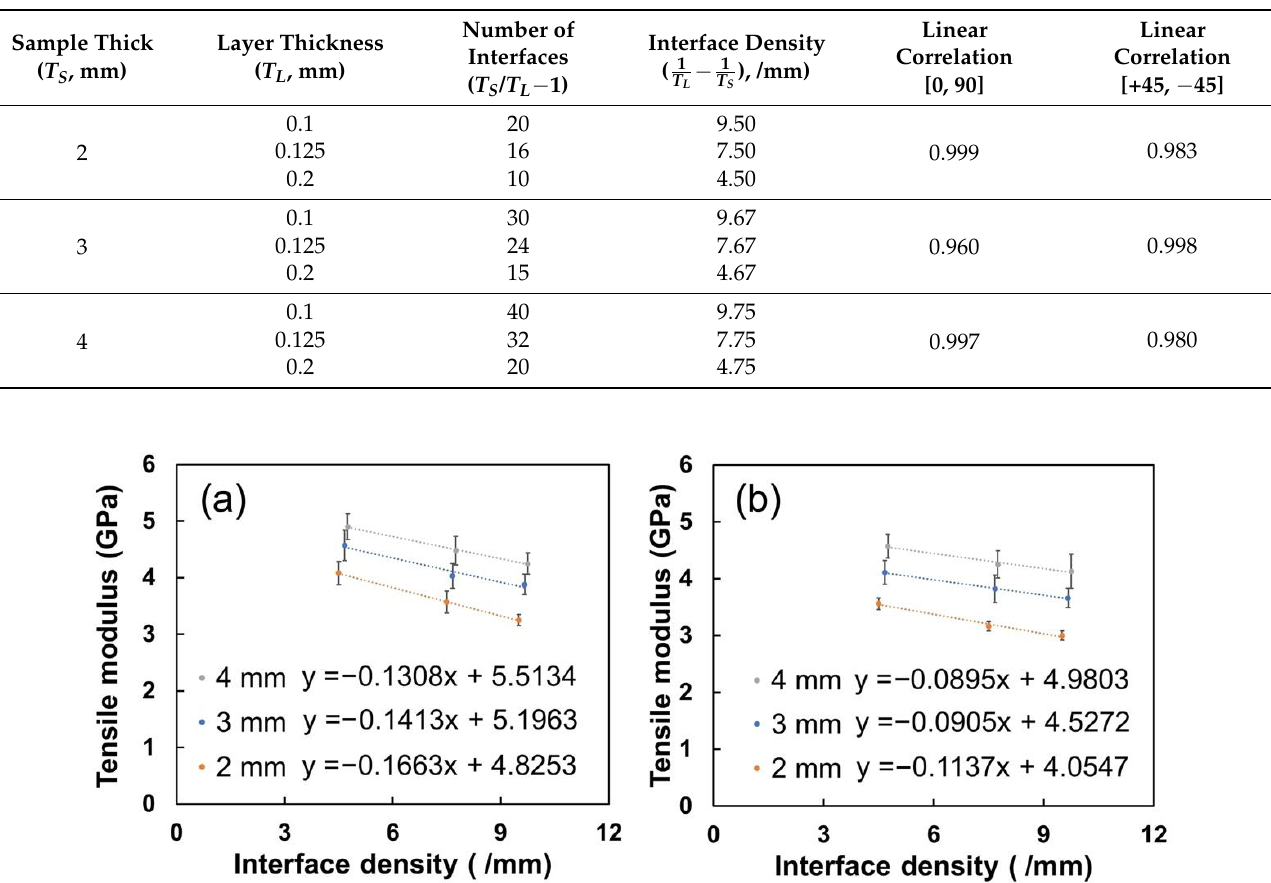
Table 5. The interface density of the printed SFRN samples.